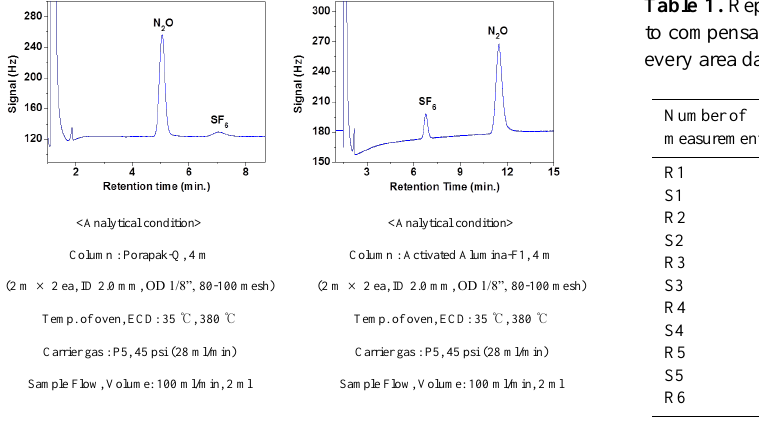
columns installed in the GC. 2